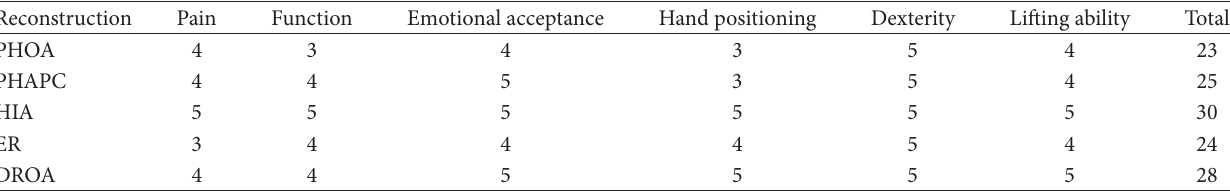
Table 2: Mean MSTS functional results comparison of different types of